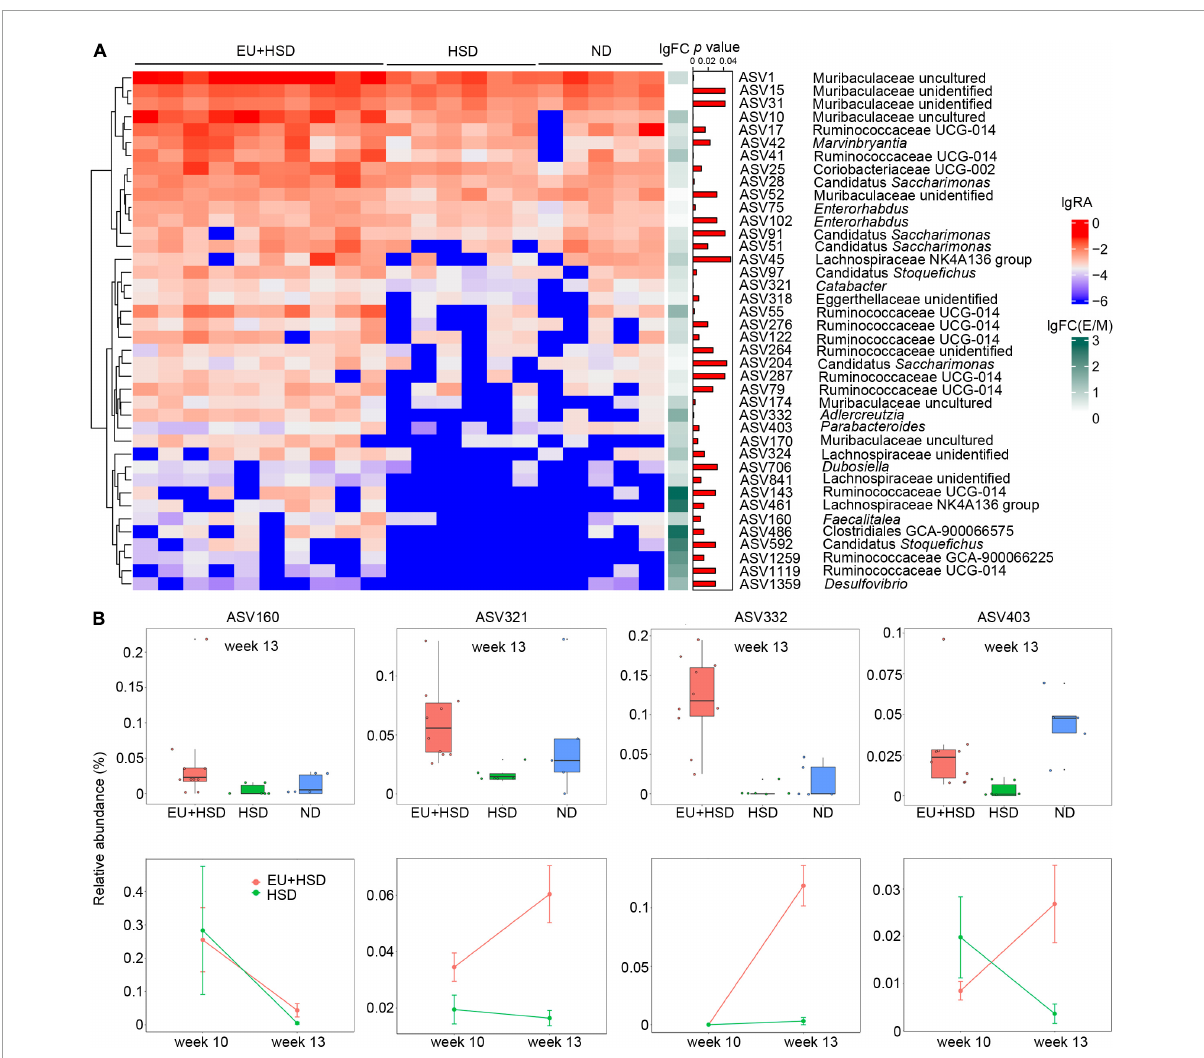
FIGURE4 ASVs upregulated by EU treatment. (A) Heatmap indicating the significantly upregulated and downregulated ASVs in the EU + HSD group compared to the HSD group. (B) Relative abundances of four upregulated ASVs ( p < 0.01, EU + HSD vs. HSD group > 3-fold difference) with classified genera in the EU + HSD, HSD, and ND groups in week 13 and the EU + HSD and HSD groups in weeks 10 and 13.